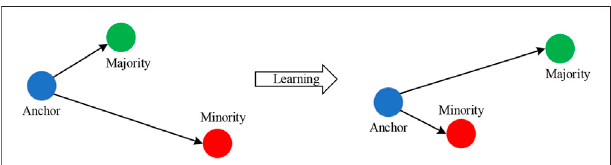
FIGURE 1 | Optimization result using triple loss